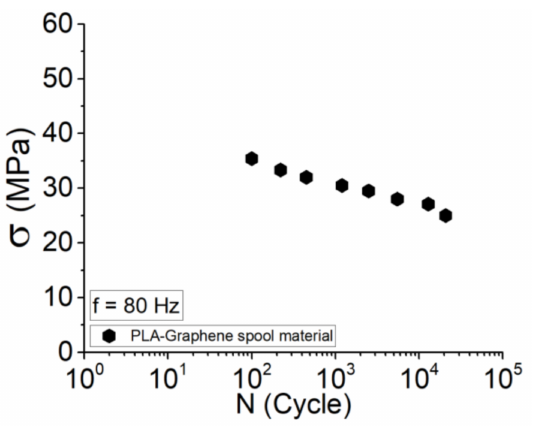
Figure 7. Wöhler curve for PLA-Graphene spool material (as-received